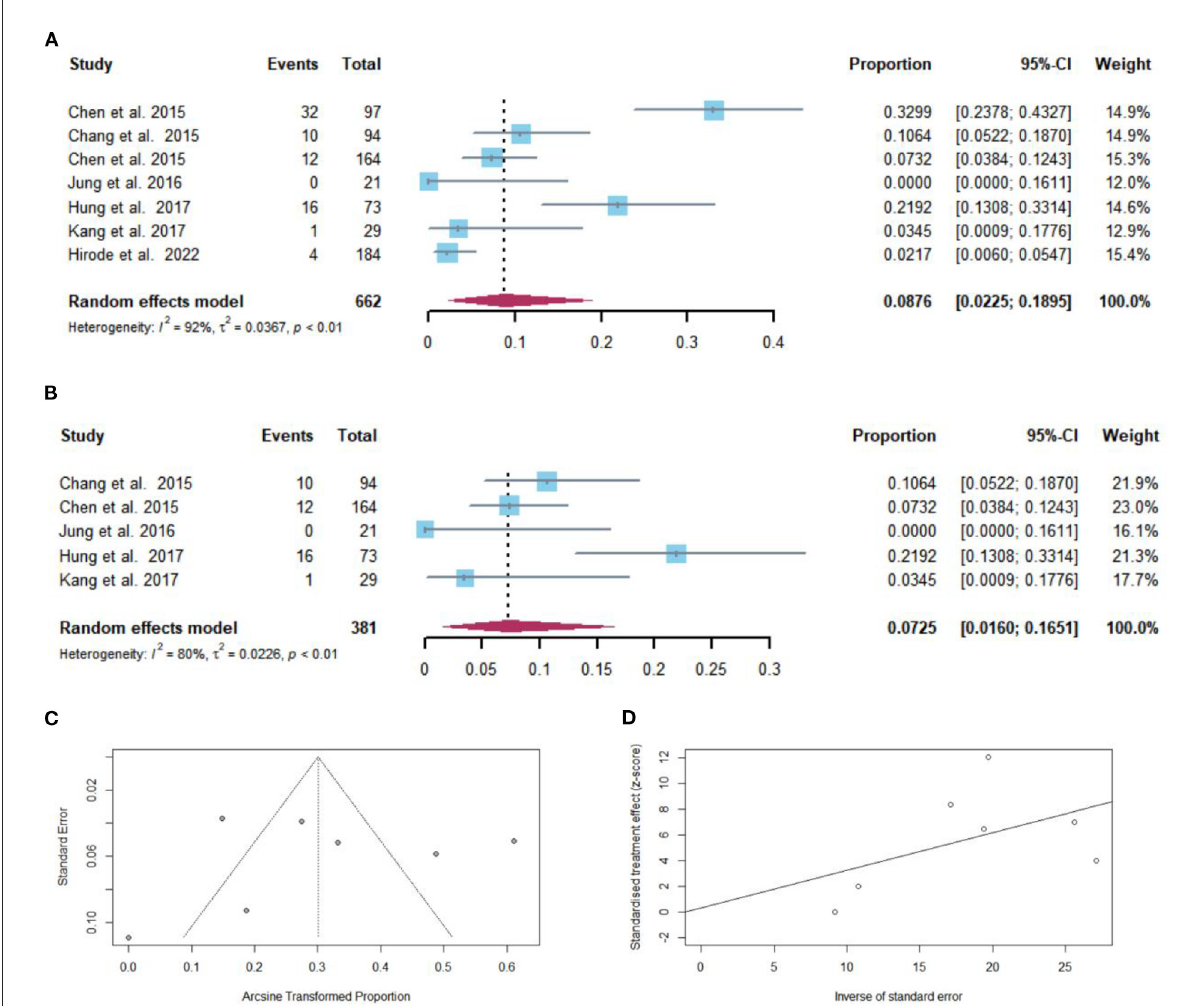
FIGURE6 (A) Individual estimates and pooled proportion of HCC development in cirrhotic patients after NAs discontinuation. (B) Sensitivity analysis of pooled proportion of HCC development in cirrhotic patients after NAs discontinuation excluding studies with high bias. (C) Funnel plot. (D) Egger’s